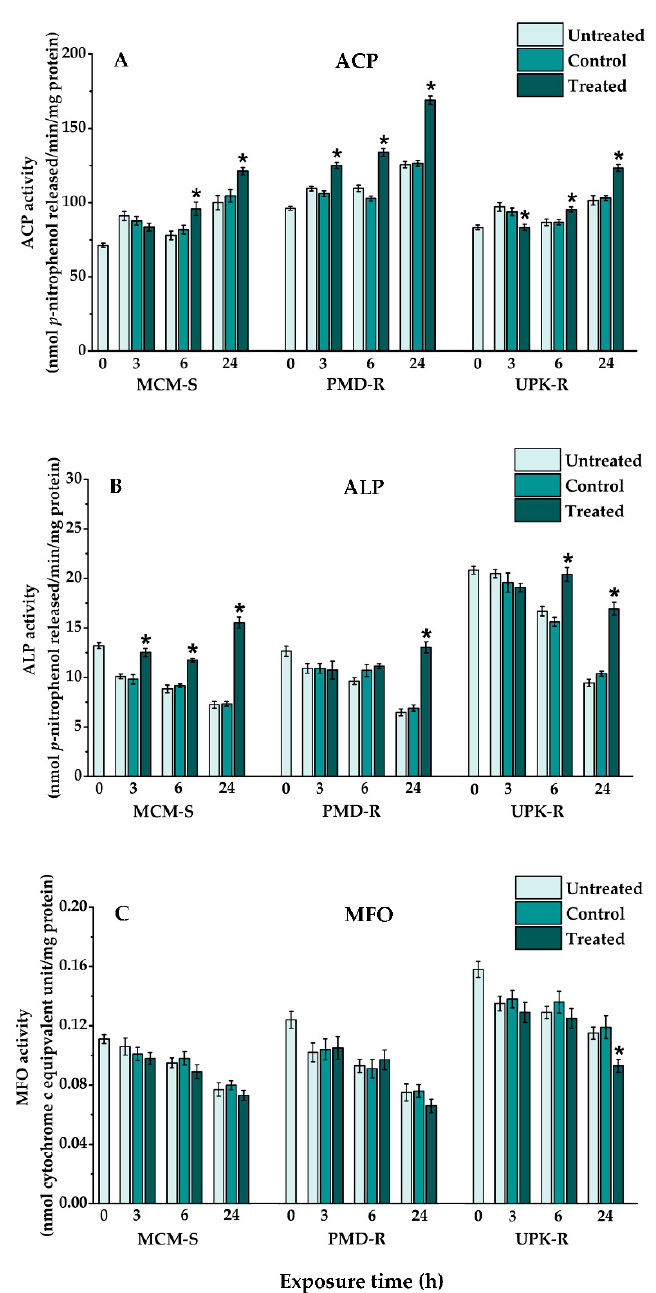
Figure 4. Activity levels of: ACP ( A ); ALP ( B ); and MFO ( C ) in 4th instar larvae of the pyrethroid- susceptible (MCM-S) and resistant (PMD-R and UPK-R) Ae. aegypti after treatment with P. crispum oil (LC 50 ) for 3, 6 and 24 h. Vertical bars represent standard error ( ± SE) of six biological samples from different preparations. The asterisk shows statistically significant differences of means among the different groups (Tukey’s HSD test, p < 0.05).